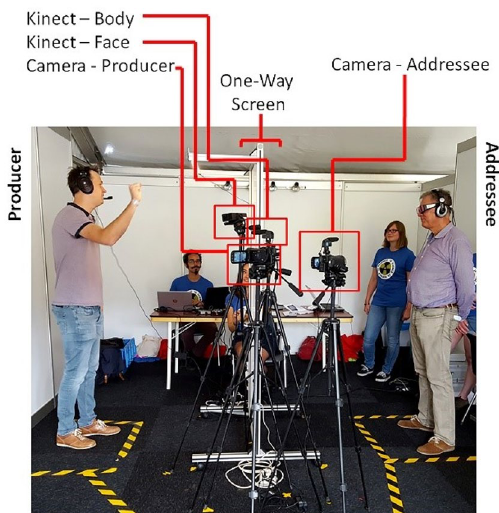
Figure 4. Overview of the physical set-up of the experiment. The producer can be seen on the left side, while the Addressee can be seen on the right side. A one-way screen separates them, allowing the addressee to see the producer, but obscuring the Producer’s view of the addressee. Two Kinects (one for face tracking and one for body tracking) are directed at the Producer. One video camera is facing the Producer, while a second video camera faces the Addressee. The yellow and black markings on the floor indicate the area in which the participants must remain throughout the